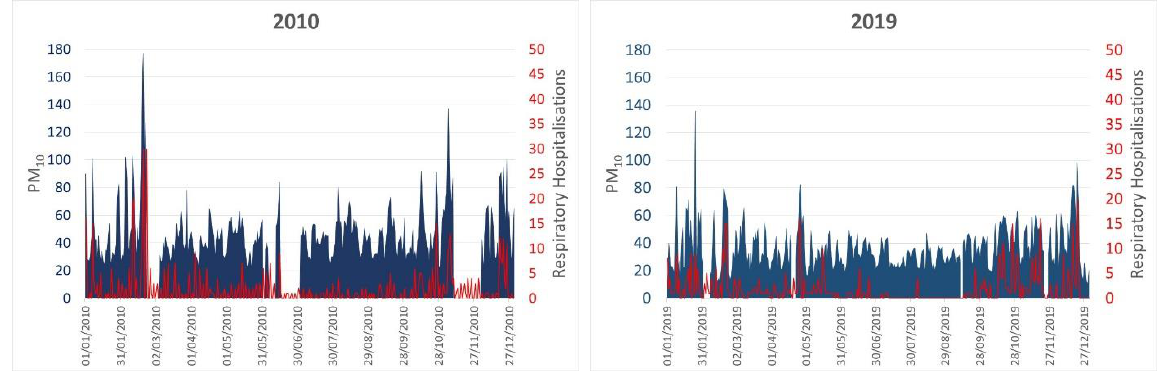
Figure 11. Timeseries of PM 10 ( μgr /m 3 ) concentrations and hospital admissions at the University General Hospital “ ATTIKON ” .